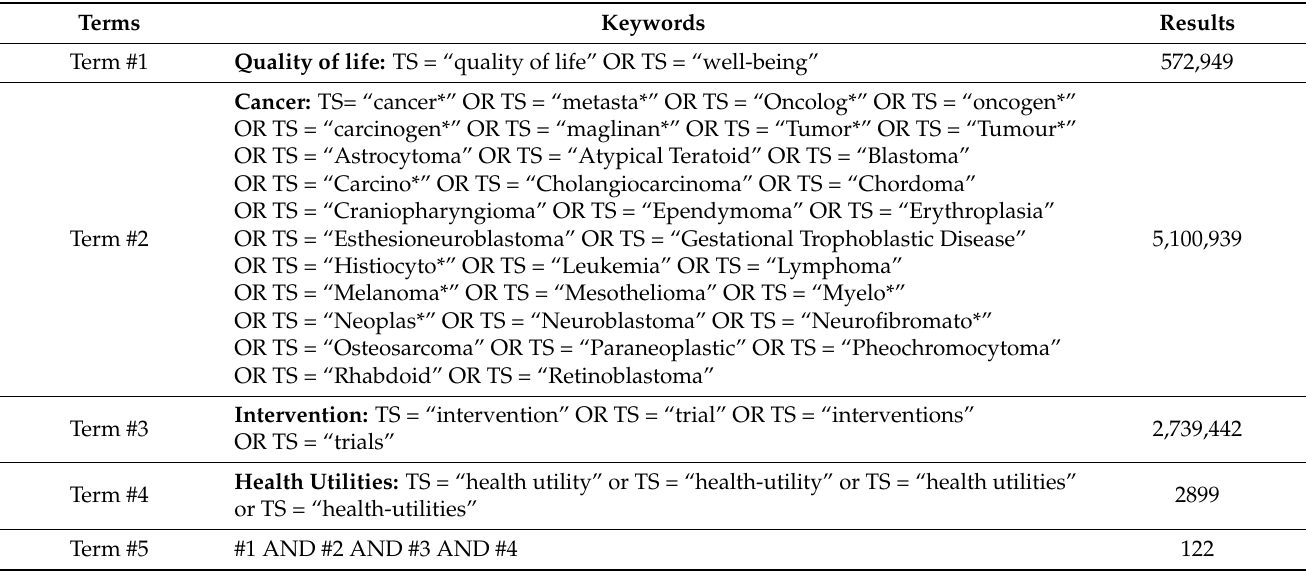
Table A1. Draft of search strategy to be used in online